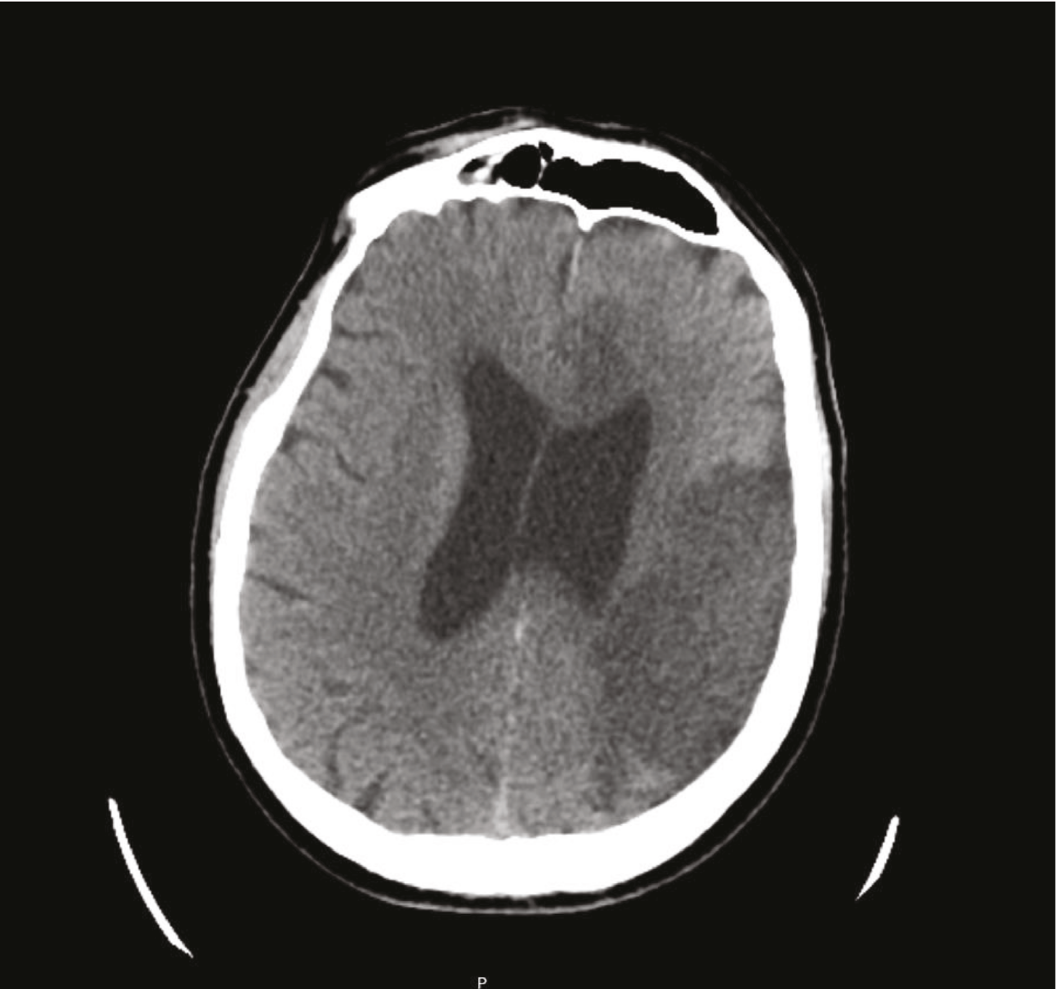
Figure 1: Noncontrast CT brain performed at the time of initial presentation, revealing established infarcts in the left MCA and ACA